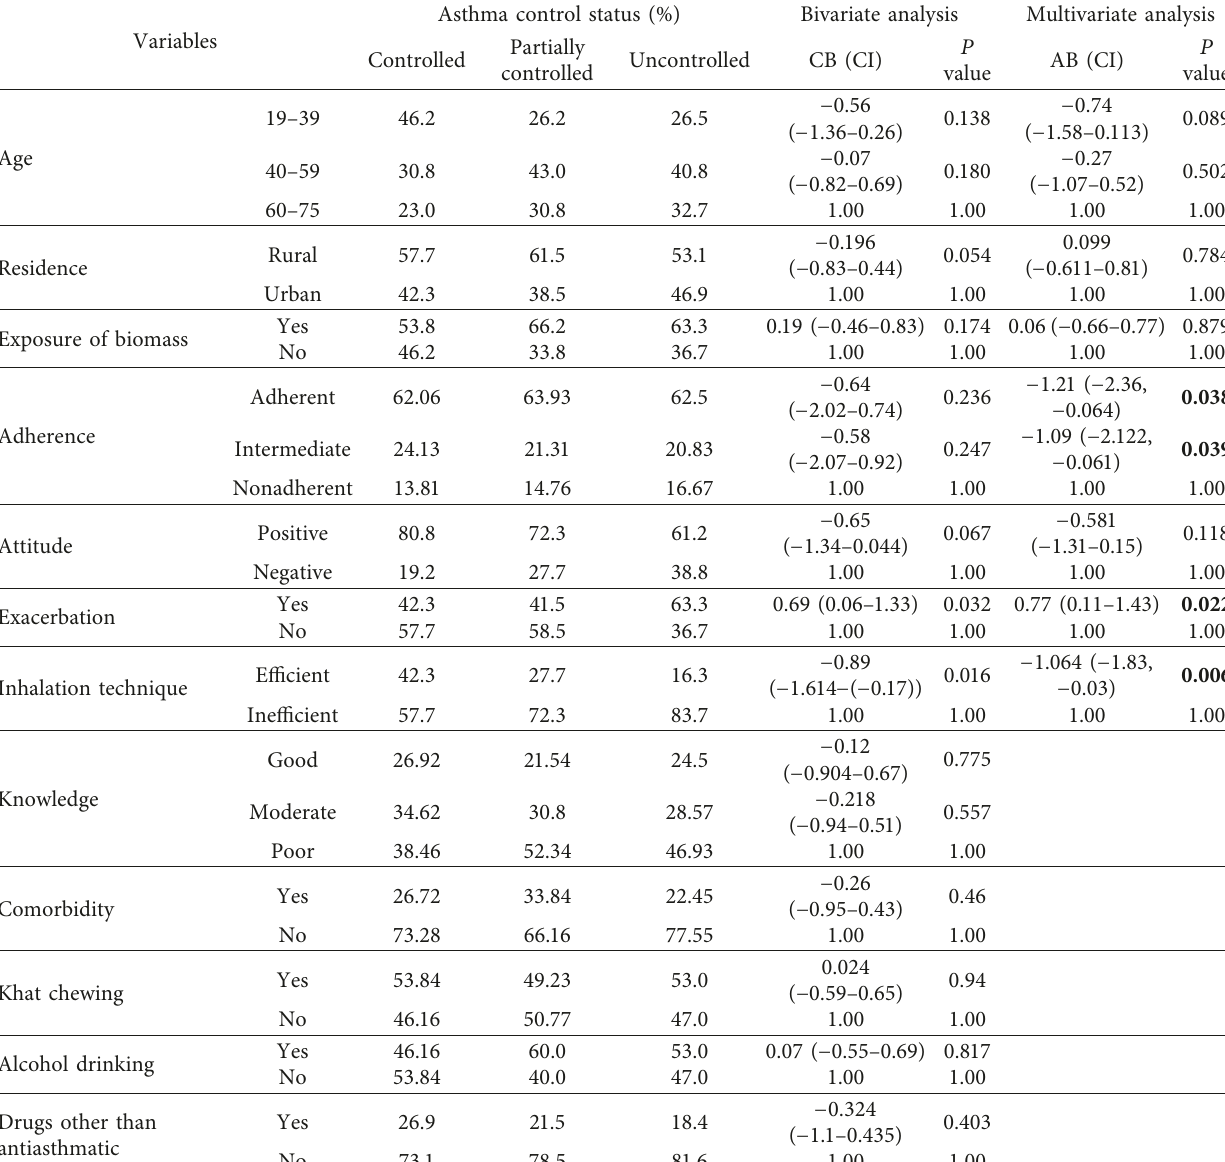
Table 2: Bivariate and multivariate ordinal regression analysis for predictors of poorly controlled asthma respiratory clinic, JUMC, Ethiopia,